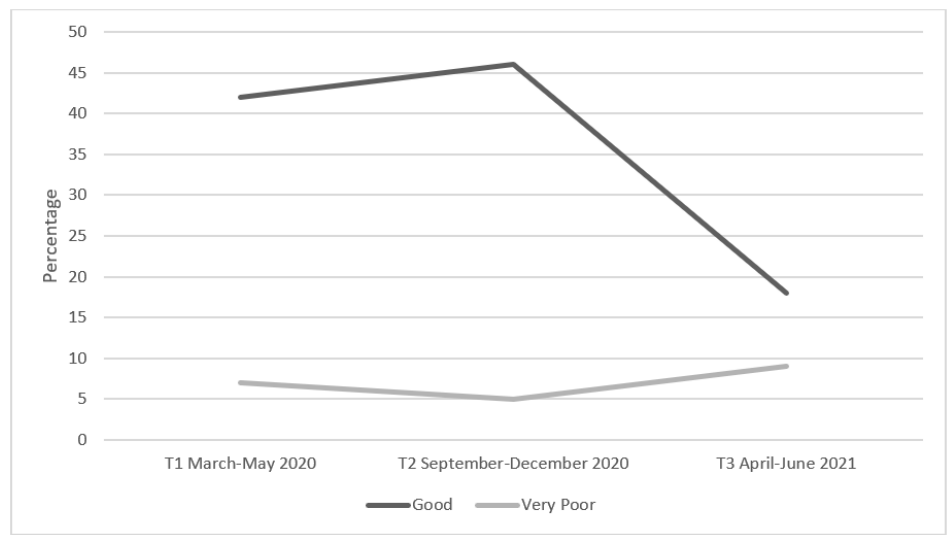
Figure 6. Percentage of participants who rated (5) ‘attending online lectures/webinars’ as ‘ Good ’ or ‘ Very Poor ’.